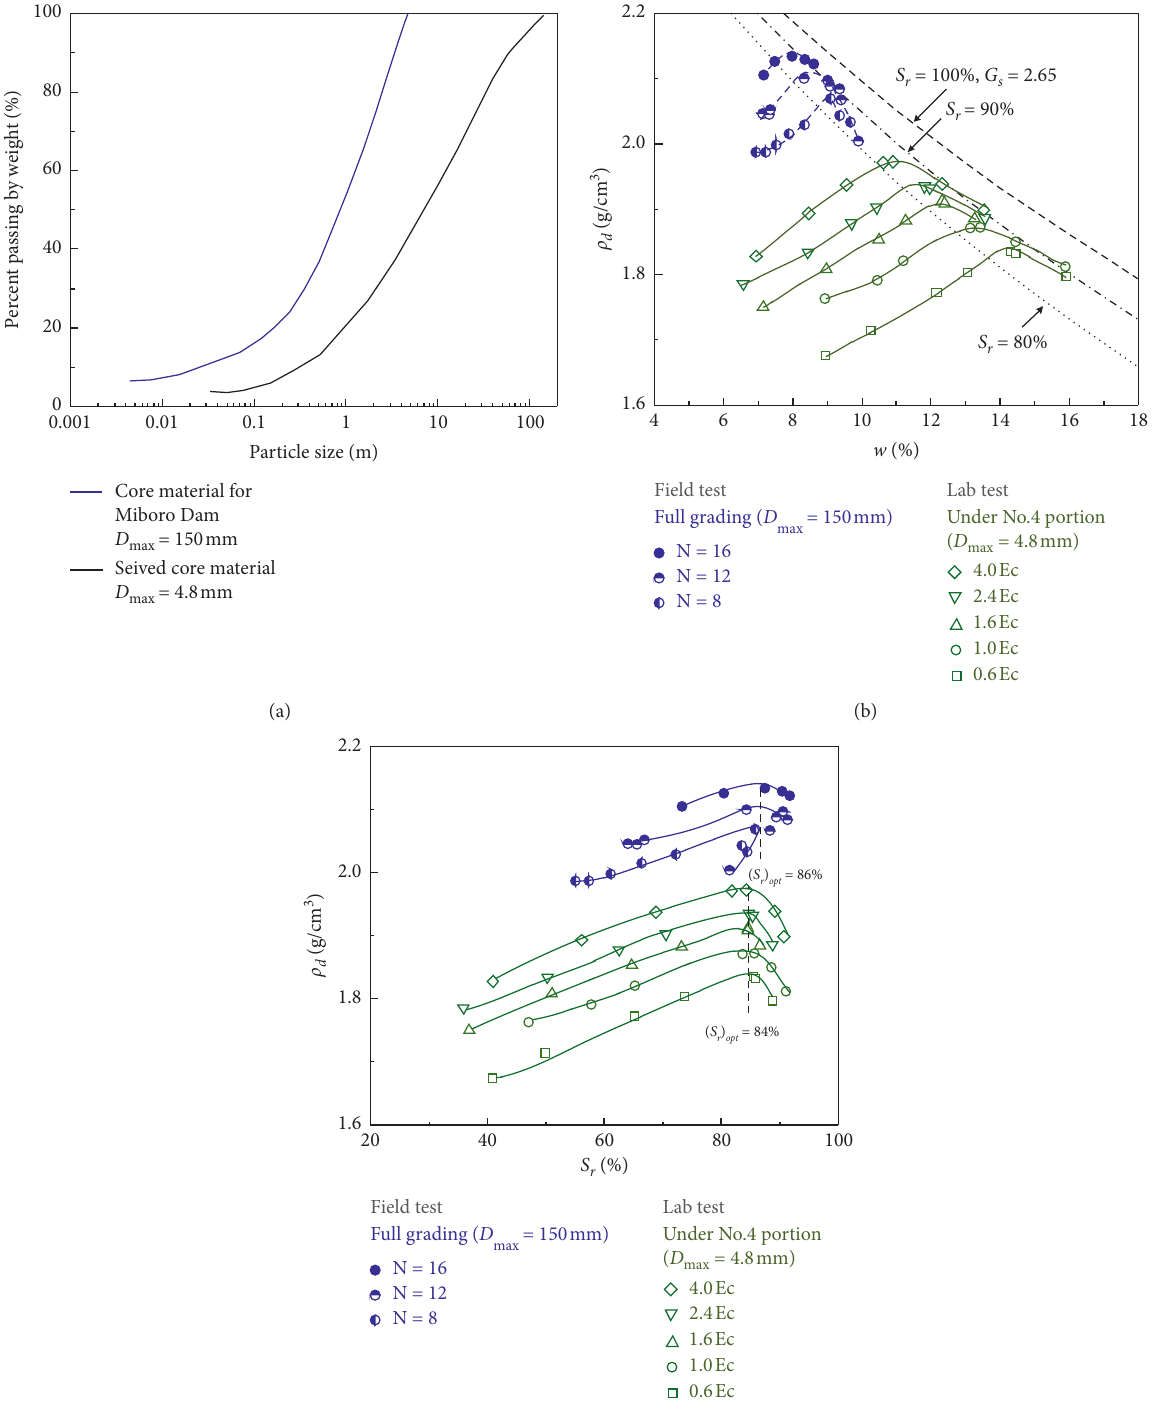
Figure 11: Core material and sieved core material of Miboro Dam site [4, 5]: (a) grading curves; (b) compaction curves; (c) dry density ρ plotted against saturation degree S r